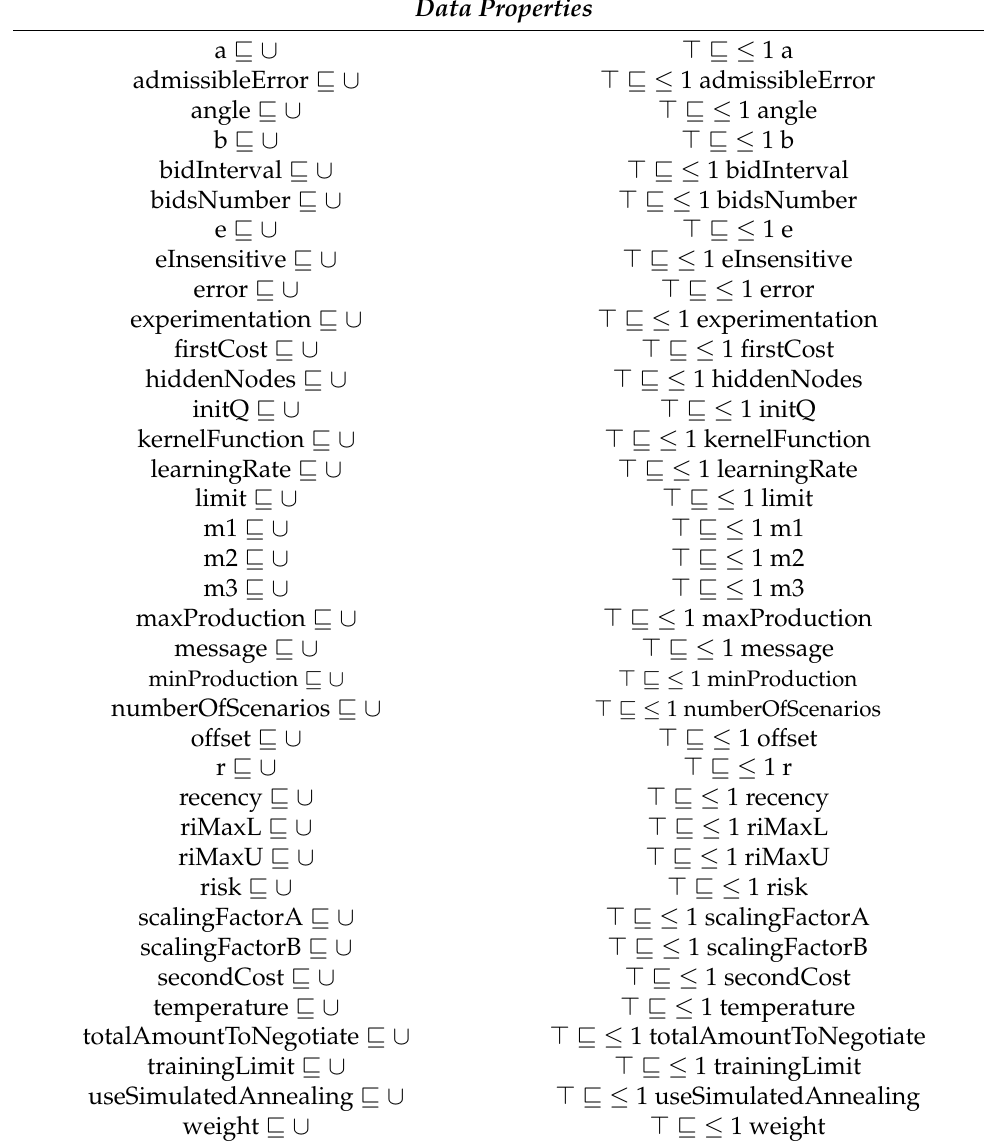
Table 2. AiD-EM Ontology data properties in DL